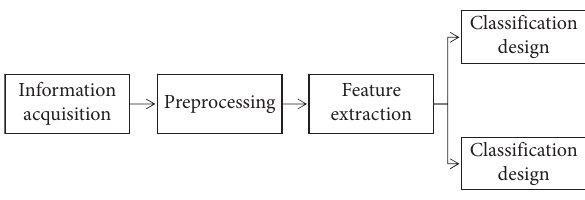
Figure 4: Basic structure of the model recognition